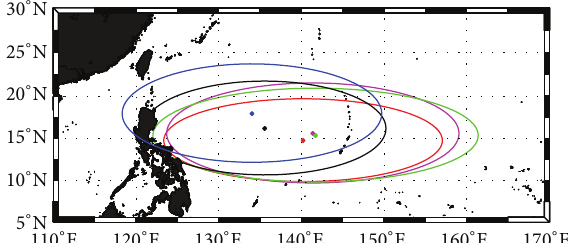
Figure 2: The average formation area of typhoon in El Ni˜no years (Red), El Ni˜no Modoki I years (Magenta), El Ni˜no Modoki II years (Green), La Ni˜na years (Blue), and normal years (Black). The semimajor and semiminor axes of an ellipse are the standard deviation of formation positions of typhoons in longitude and latitude, respectively.